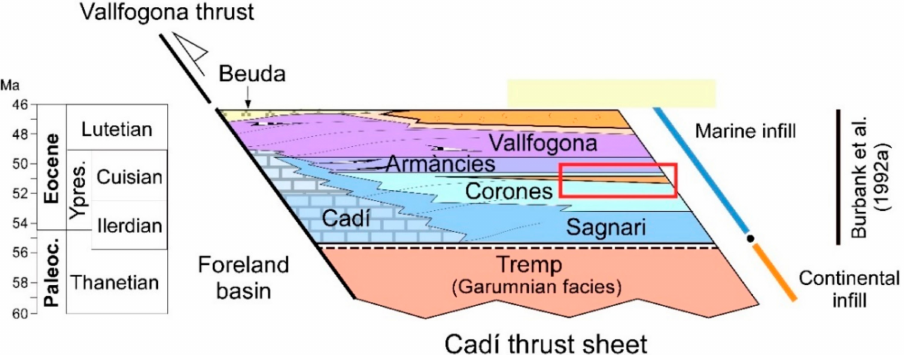
Figure 2. N–S stratigraphic panel of the Cad í thrust sheet. The age of sedimentary units was stablished according to [44]. The sedimentary record of the Cad í thrust sheet was separated into Paleocene continental deposits and Eocene marine formations. The red box indicates the stratigraphic position of the studied